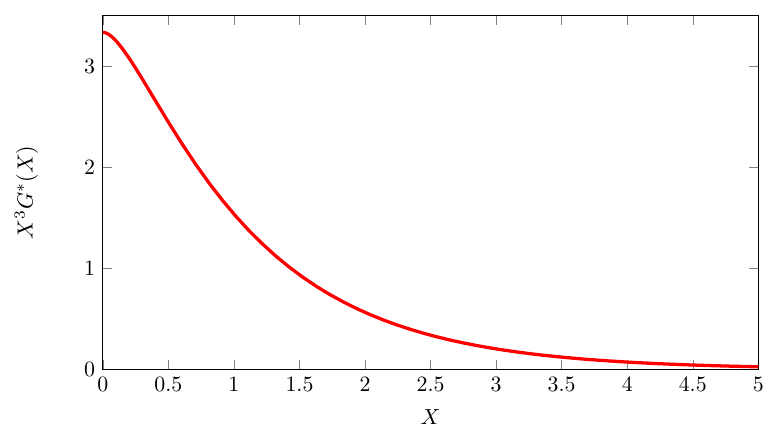
units of the skeleton function X 3 G ∗ ( X ) in eq. (3.34) versus X Figure 2 . Plot in α π